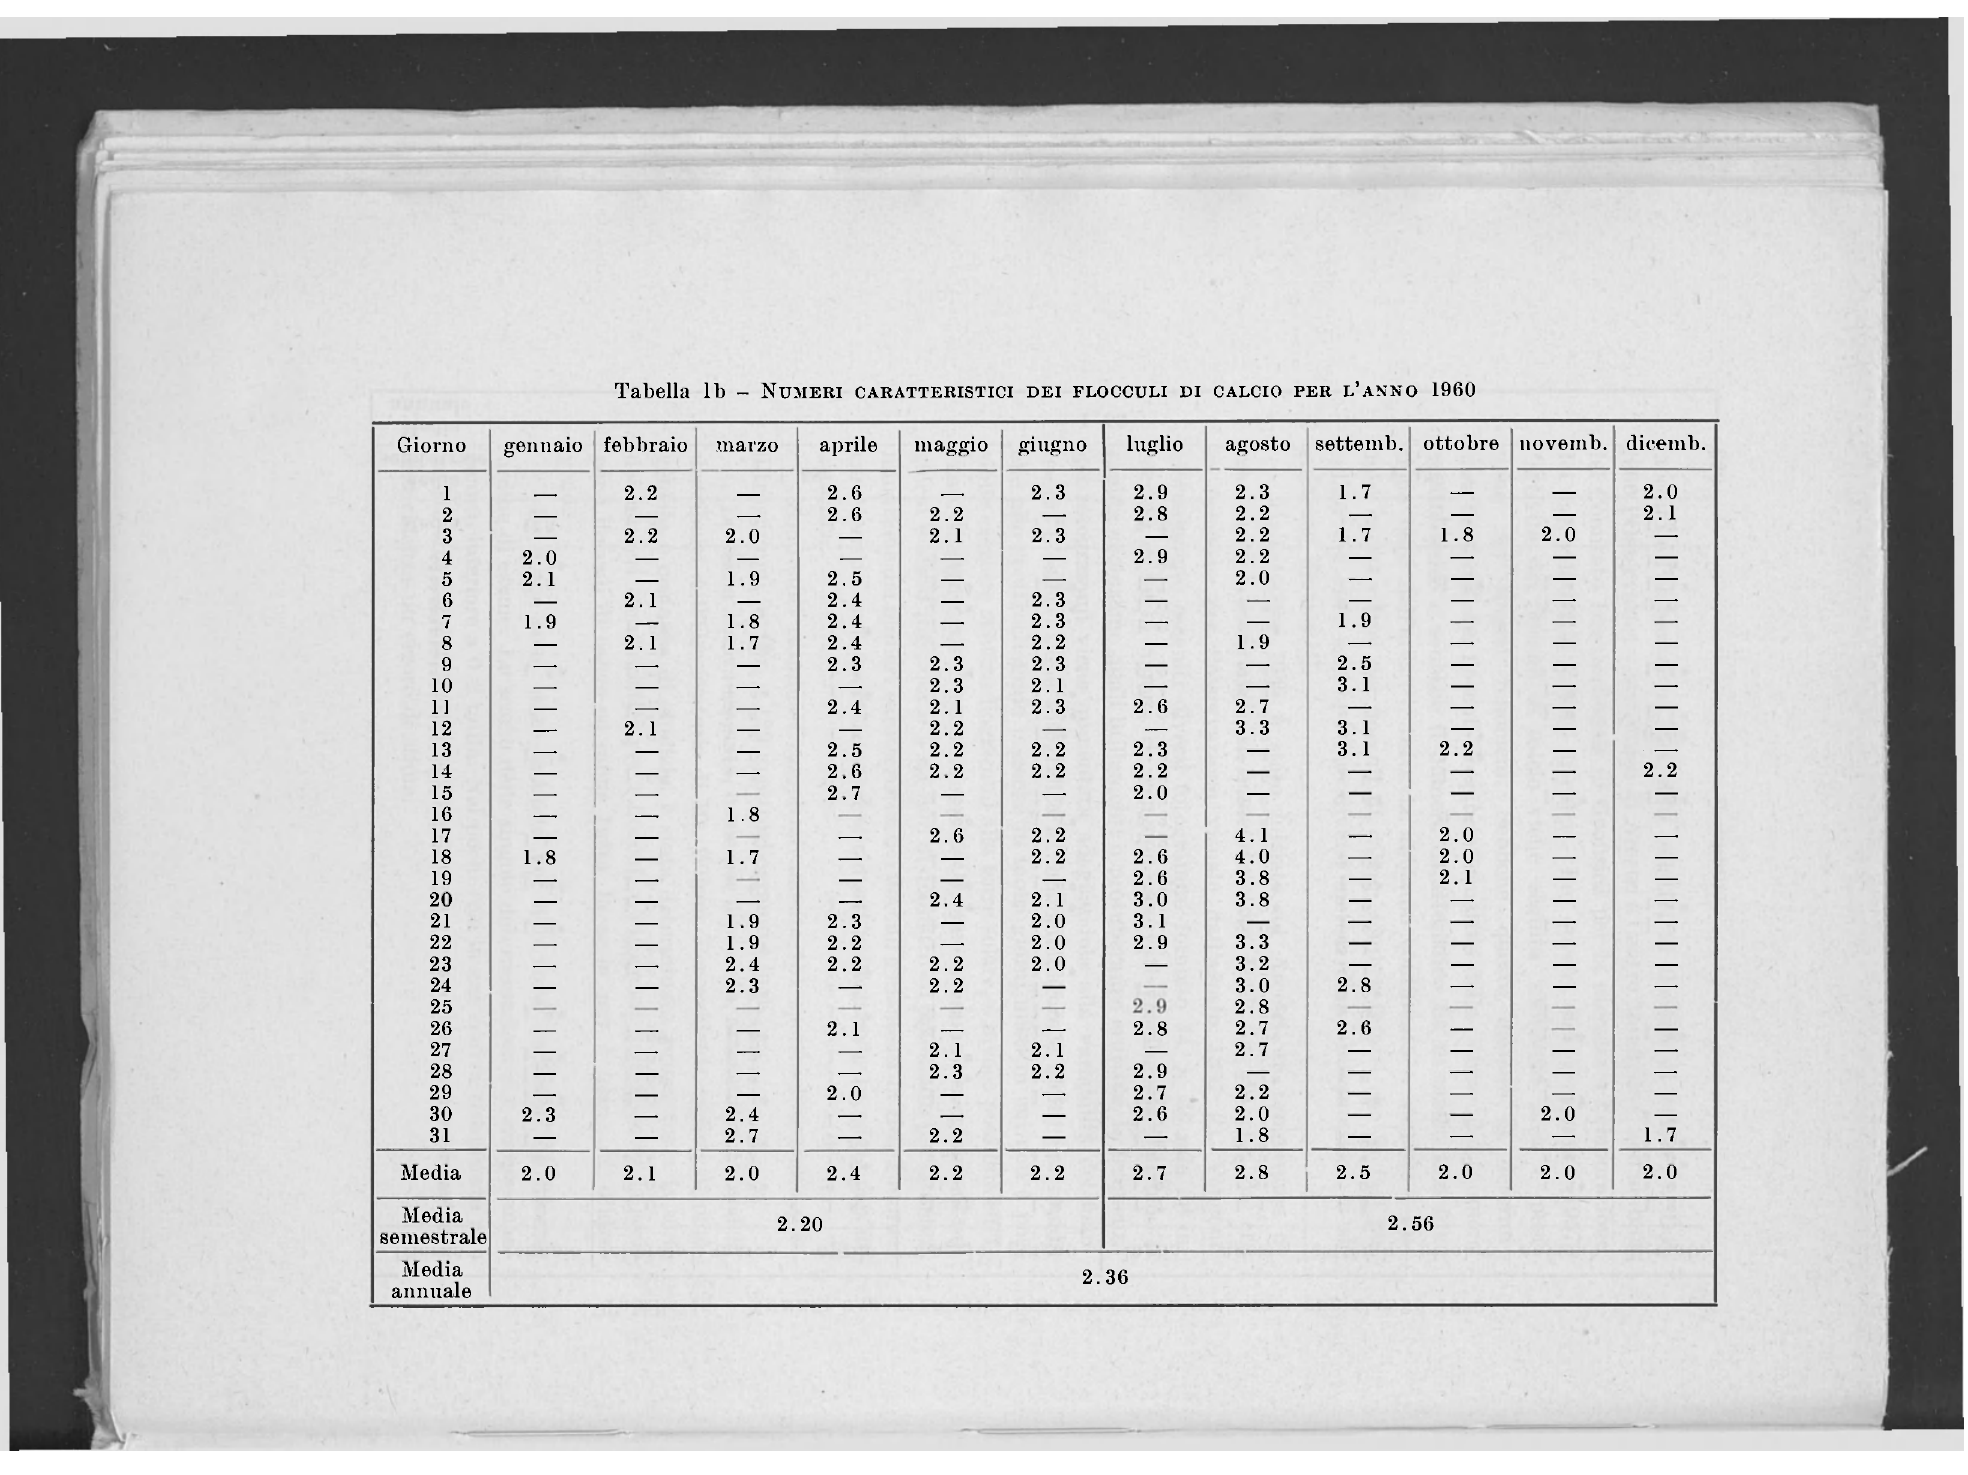
marzo aprile maggio giugno luglio agosto settemb. ottobre noveinb.